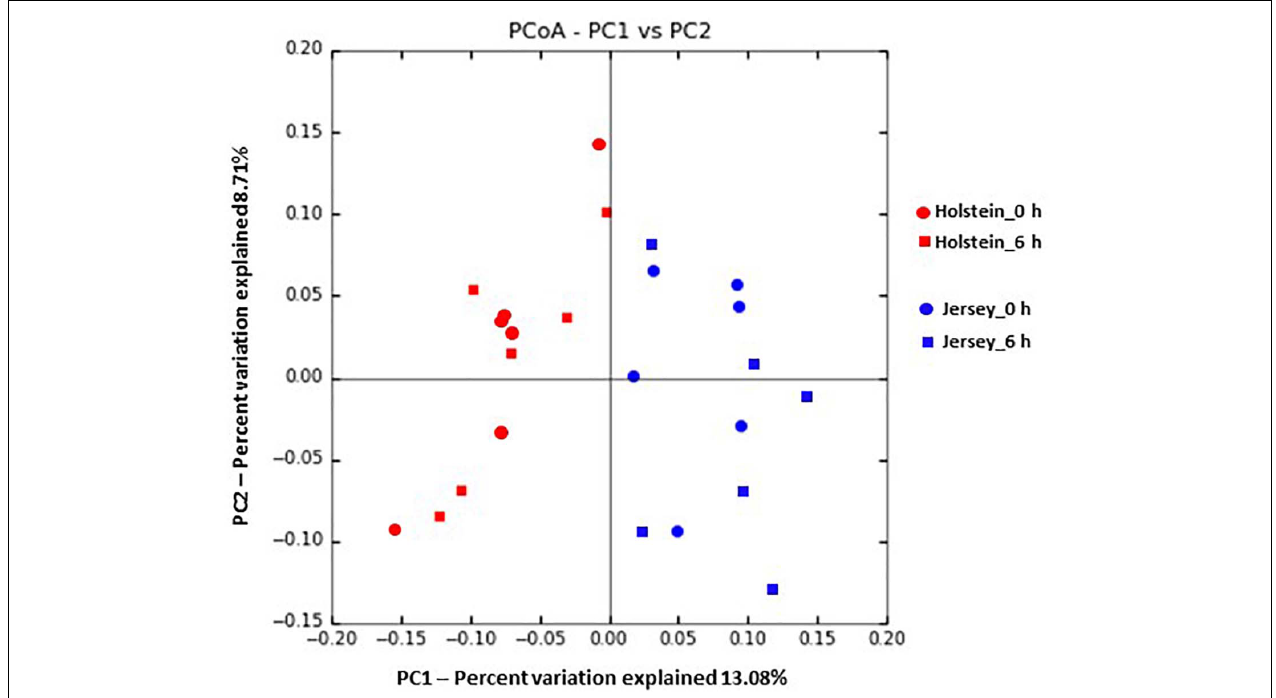
FIGURE 4 | Principal coordinates analysis plot based on unweighted-Unifrac distance showing the comparison of the overall rumen microbiota of the Holstein and the Jersey steers.